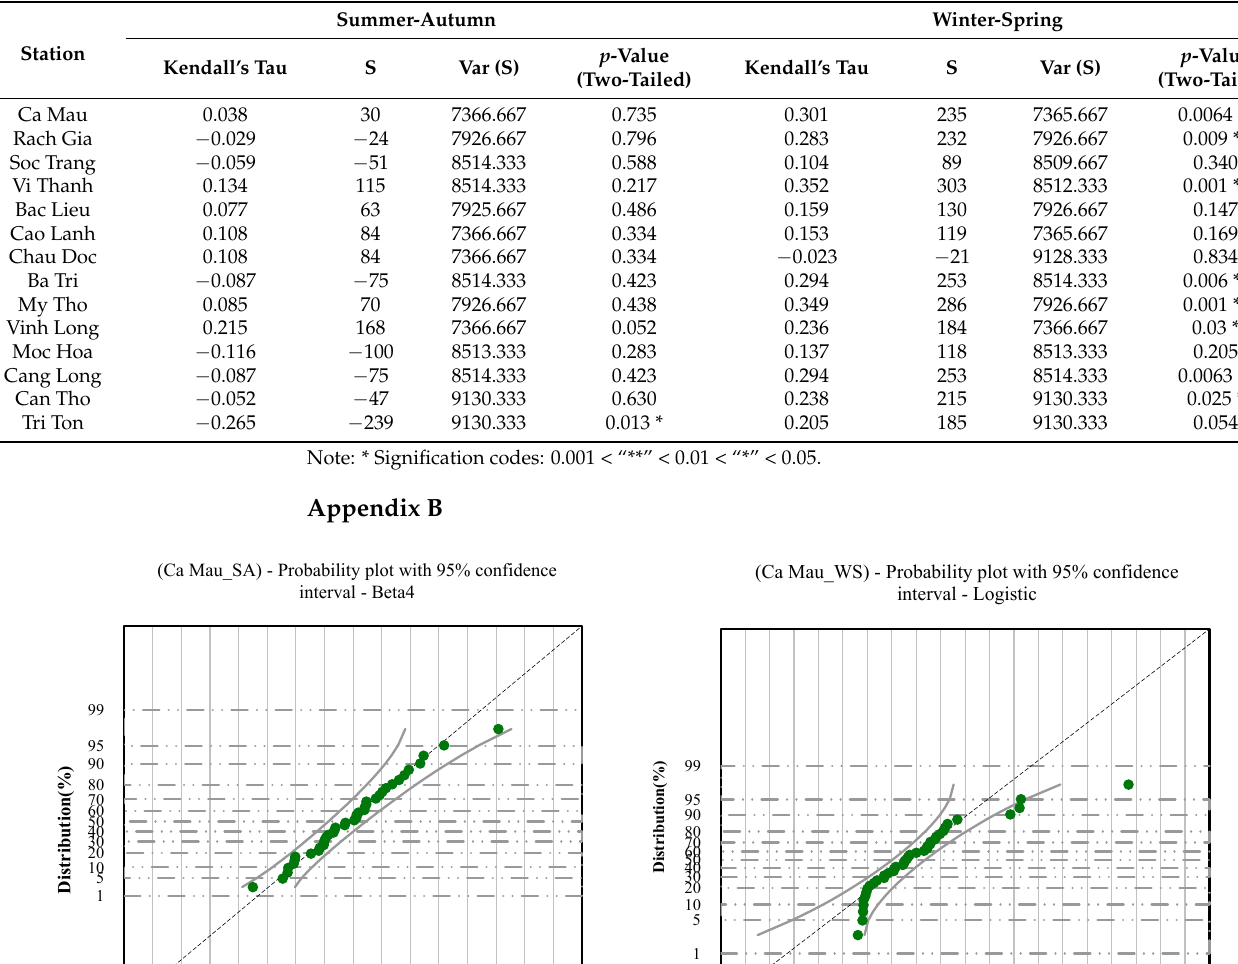
Table A1. Mann ‐ Kendall test trend for rice cropping SPI seasons.